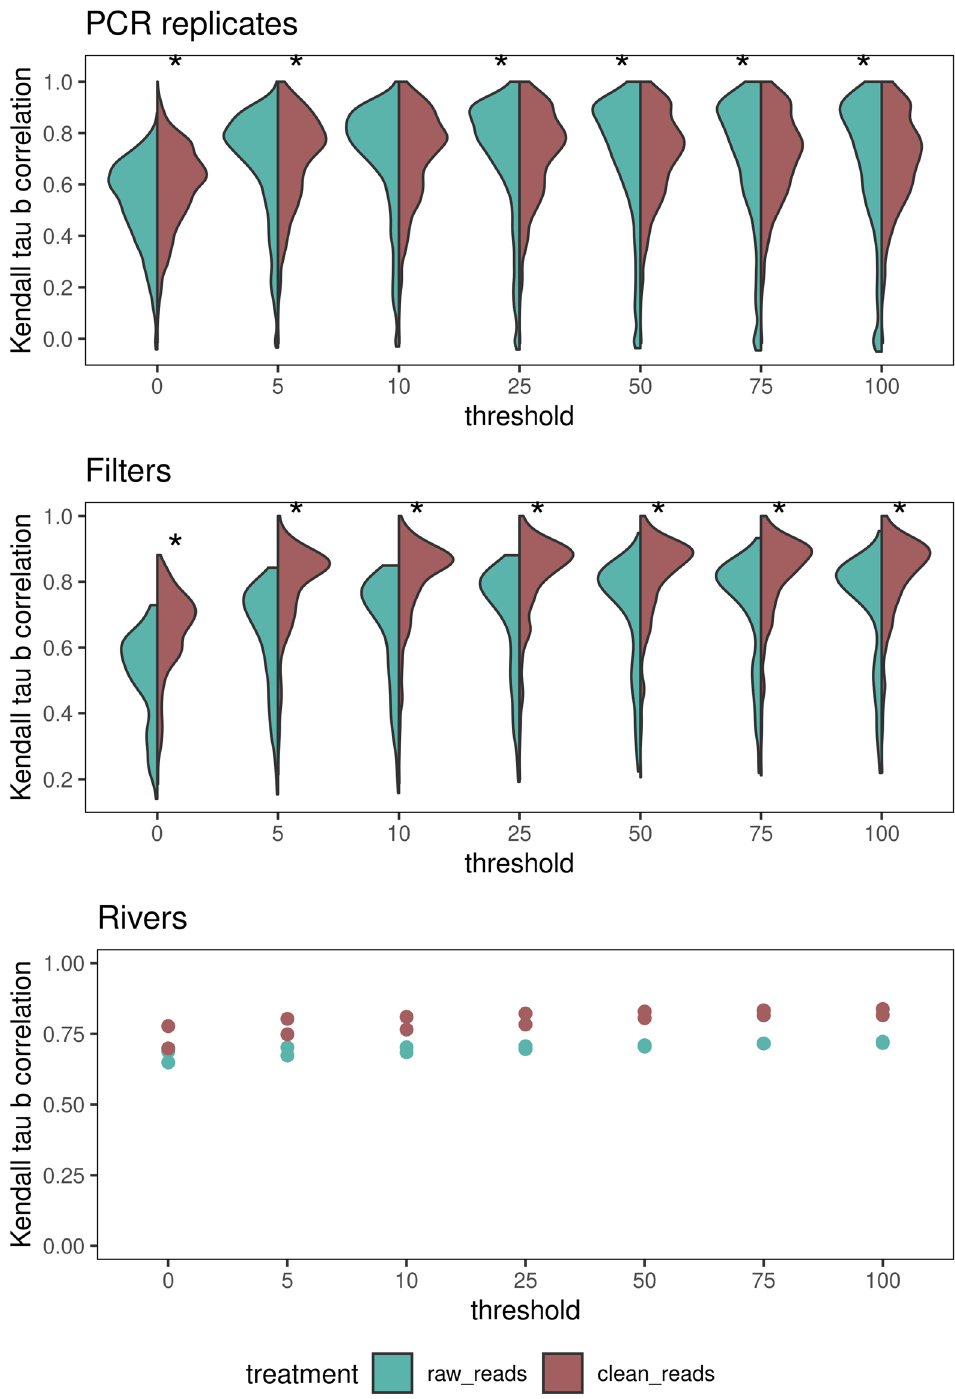
Figure 2. Kendall Tau-b correlation coefficient between the outputs of the CNN and OBITools. The left side of the violin plots (blue) displays correlation values between OBITools and the CNN applied to raw reads. The right side of the violin plots (red) displays correlation values between OBITools and the CNN applied to clean reads. The x-axis represents the threshold of the minimum read number per species for the species to be considered present. Stars represent a significant difference between the two correlations. The analysis was made at three levels: PCR replicates (top), eDNA filters (middle), and rivers